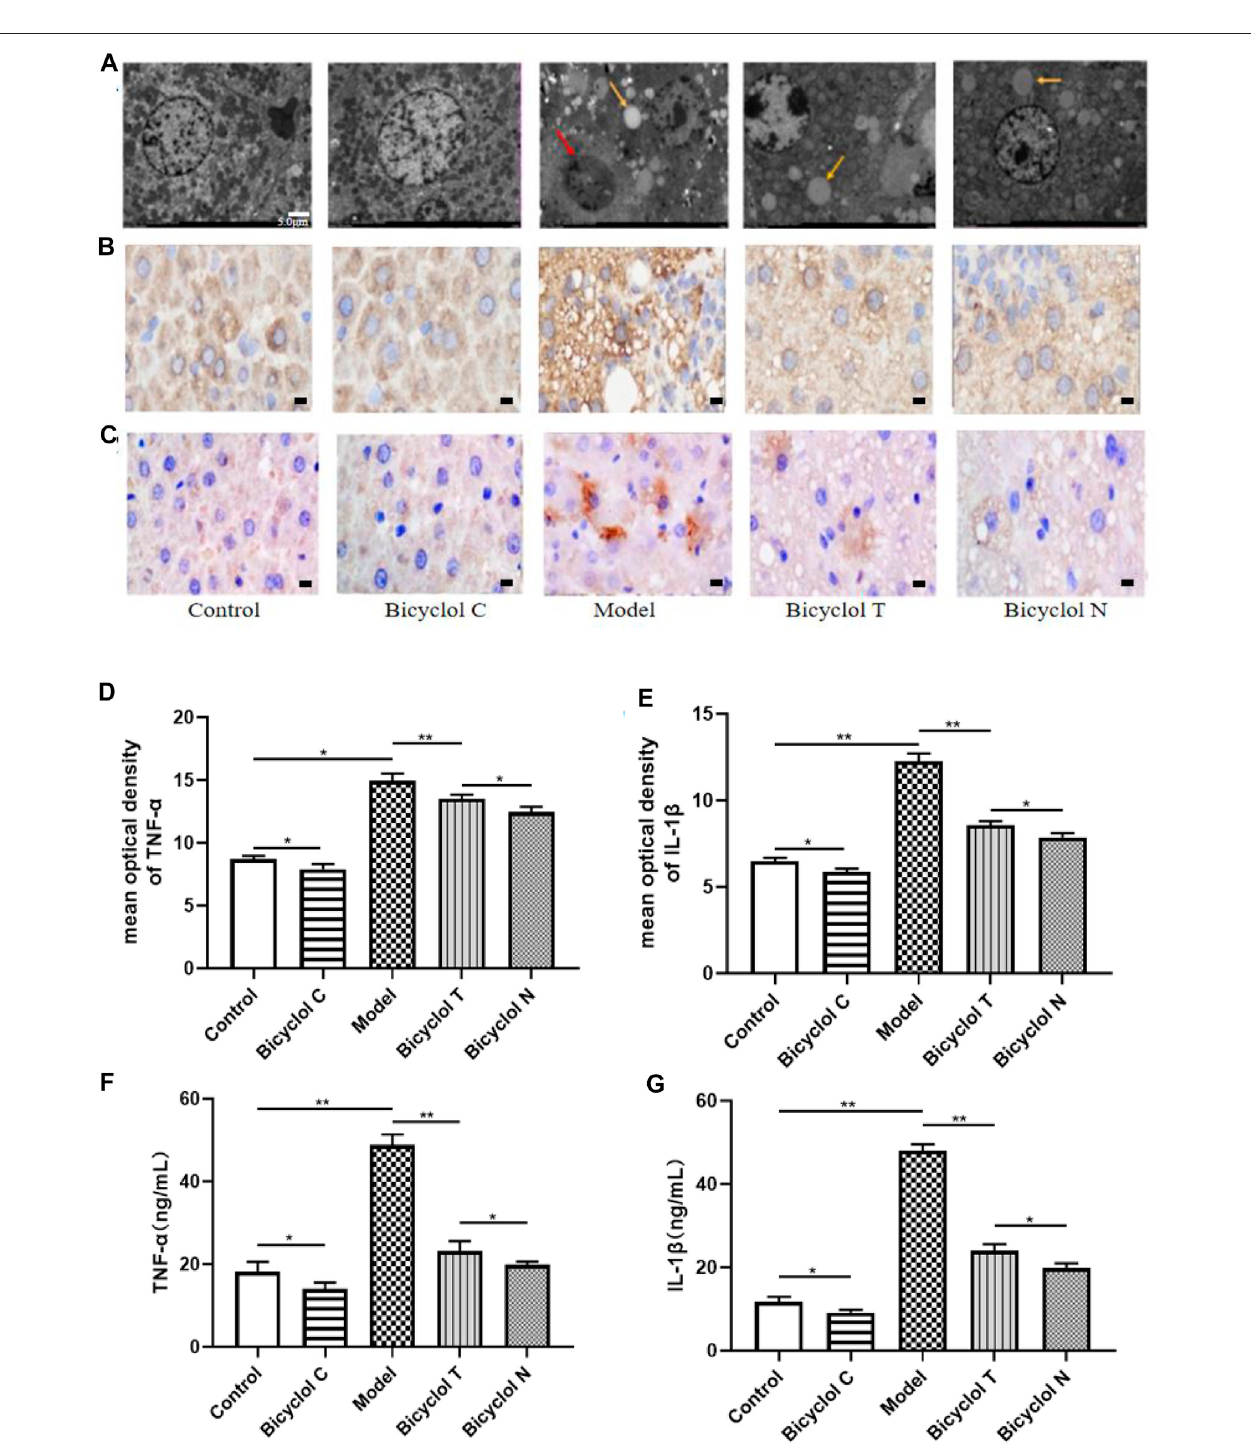
FIGURE5| Effectofbicyclolonliverandserumin fl ammationinT2DMwithNAFLDrat (A) TEMimages(*1.5 k)fromTEMshowingcharacteristicin fl ammasome(red arrow)andlipiddroplets(yellowarrow)inlivers. (B) TheexpressionofTNF- α determinedbyIHC. (C) TheexpressionofIL-1 β determinedbyIHC. (D) Meanopticaldensity analysis ofTNF- α expression in liver. (E) Mean optical density analysisof IL-1 β expression in liver. (F) The levels of TNF- α in serumv (G) The levels of IL-1 β in serum. Data are presented as means ± SD. * p < 0.05. ** p < 0.01.